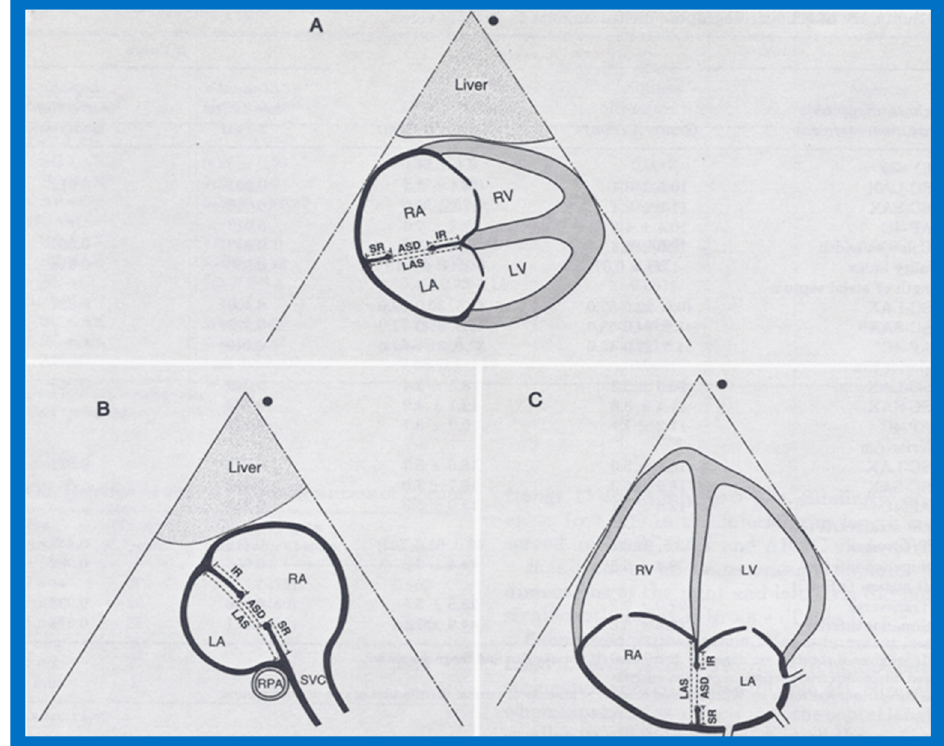
Figure 13. Line drawings of the atrial septum along with the atrial septal defect (ASD) in multiple echo projections, namely, subcostal long axis ( A ), subcostal short axis ( B ), and apical four chamber ( C ), illustrating the methods of measurement of sizes of the defect, length of the atrial septum (LAS), and inferior (IR) and superior (SR) rims of the ASD. Left atrium (LA), left ventricle (LV), right atrium (RA), right pulmonary artery (RPA), and right ventricle (RV), and superior vena cava (SVC) are marked. Replicated from Reference [27].